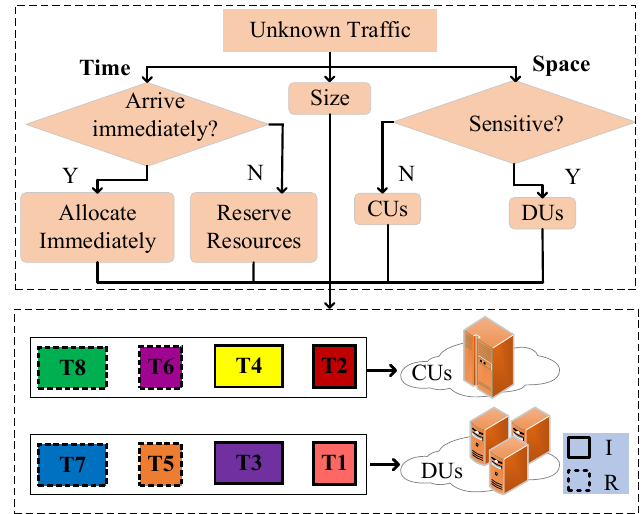
Figure 6. Priority-based proposed TDTS scheme.